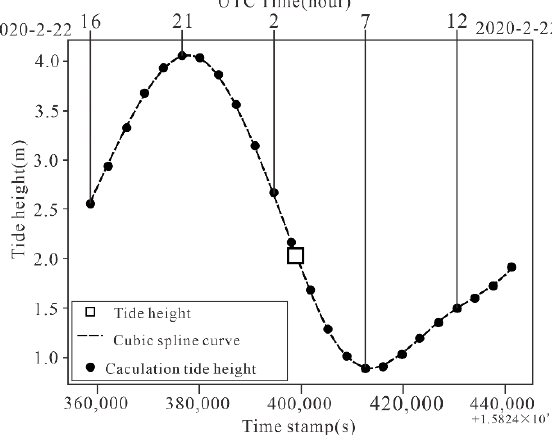
Figure 6. Calculation of tide height at the epoch of satellite flight.